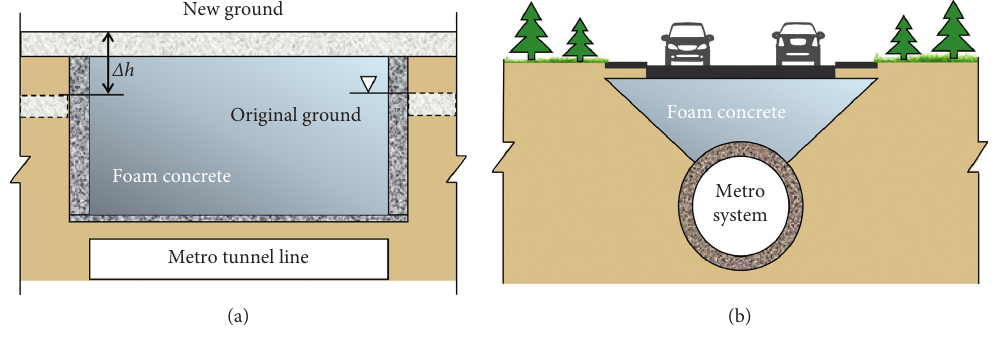
Figure 6: FC application in metro system.